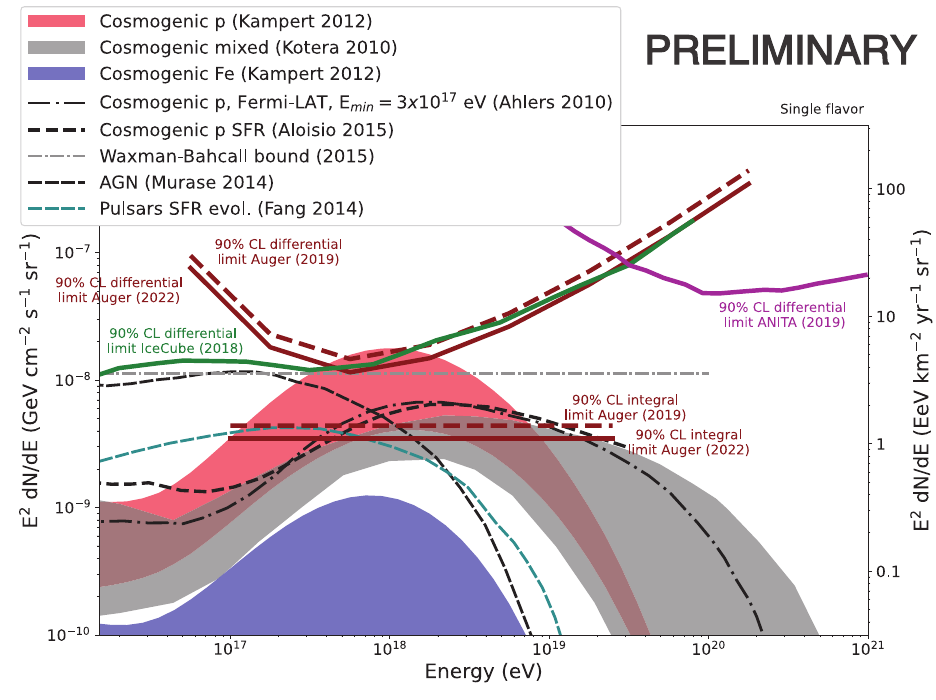
Figure 5. Updated upper limits on the di ff use flux of neutrinos, both the integral (straight solid line) as well as di ff erential (curved solid line); for comparison, also the corresponding upper limits from [16] are shown; included are also upper limits from IceCube and ANITA and the expected neutrino fluxes under di ff erent theoretical assumptions and scenarios; for a full list of references, see